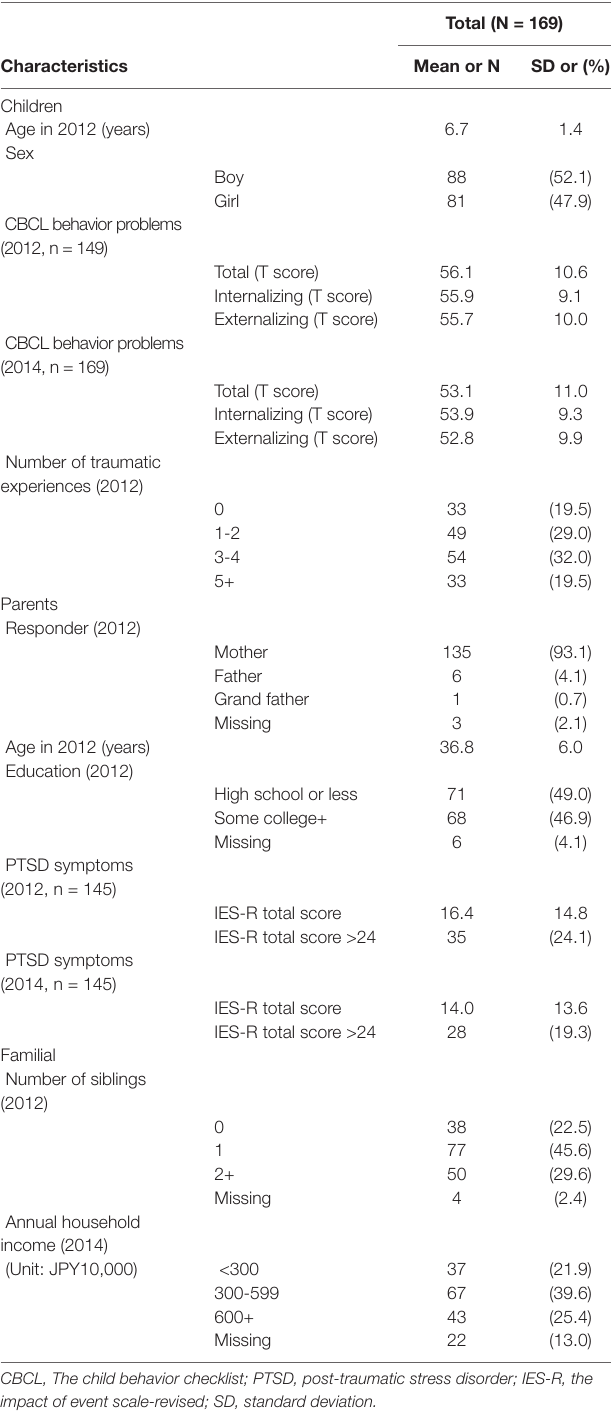
TABLE 1 | Demographic and familial characteristics of participants at baseline (2012) and children’s behavioral and maternal mental health problems at both baseline and follow-up